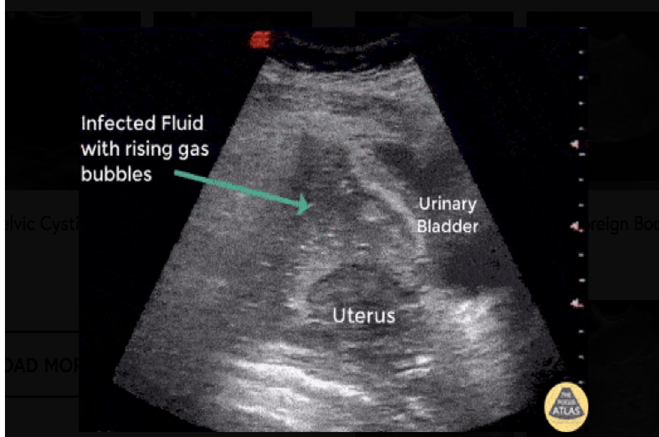
Figure 2. Ultrasound demonstrating pelvic free fluid and rising gas bubbles, indicative of uterine perforation. Image courtesy of Robert Jones, DO, POCUS Atlas. Available at https://www. thepocusatlas.com/ob-gyn-atlas.